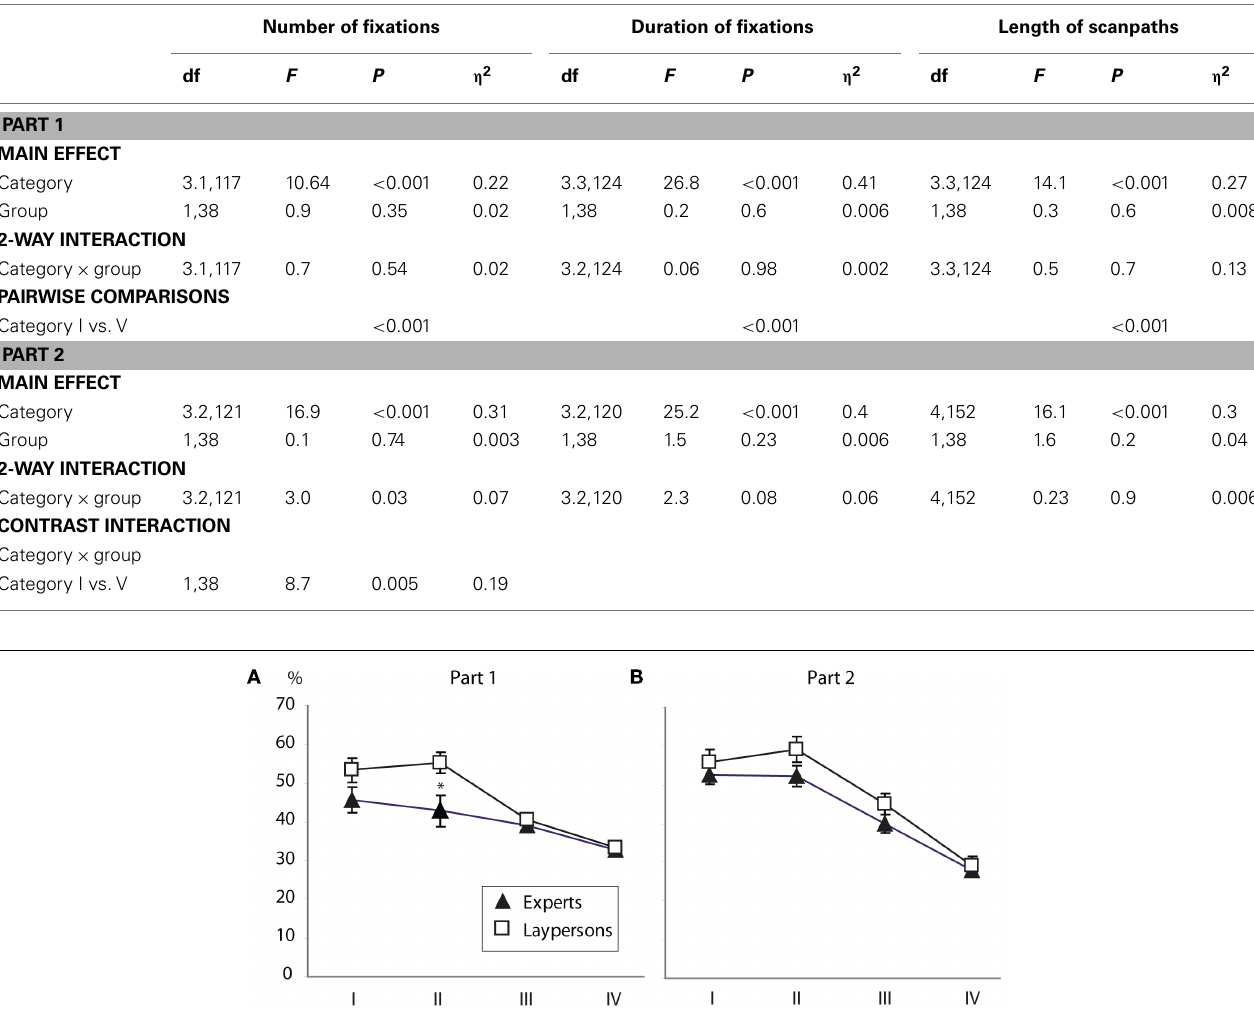
Table 3 | Results of statistical analyses for number and duration of fixations and length of scanpaths for Part 1 and Part 2.